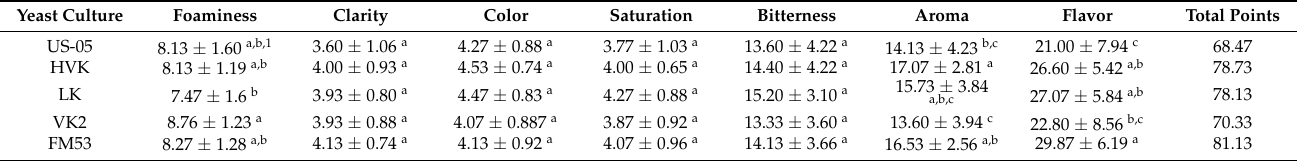
Table 5. Results of the sensory analysis of the